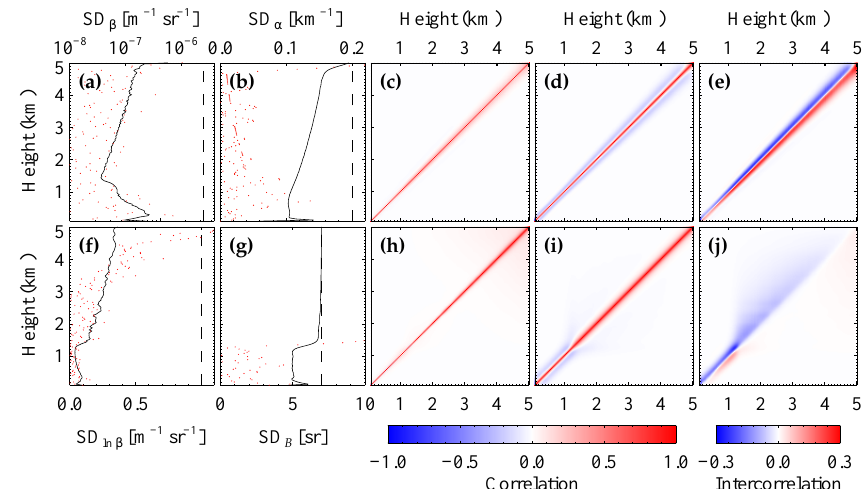
Fig. 8. Covariance matrix for the retrieval of case a by the linear and log modes (top and bottom rows, respectively). (a) Backscatter standard deviation, being the diagonal of the covariance matrix. The absolute difference between the simulated profile and retrieval is shown in red. (b) Extinction standard deviation. (c) Backscatter autocorrelation. (d) Extinction autocorrelation. (e) β ( p ) vs. α ( p ) error intercorrelation. (f) Log backscatter standard deviation. (g) Lidar ratio standard deviation. (h) Log backscatter autocorrelation. (i) Lidar ratio autocorrelation. (j) ln β ( p ) vs. B error intercorrelation. cover all sources of